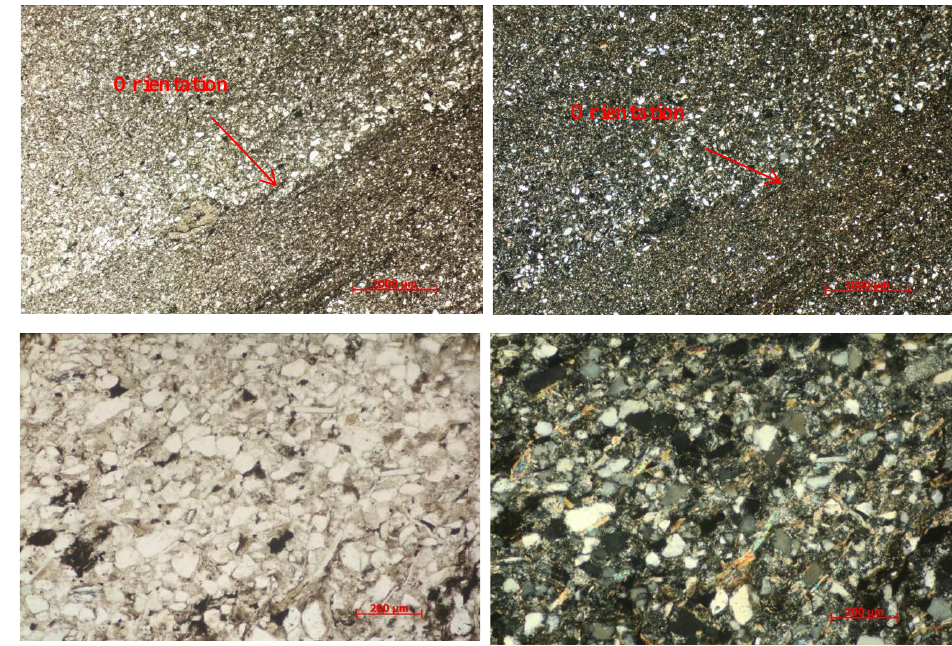
Figure 2. Cathodoluminescence picture near the beddings for slate.